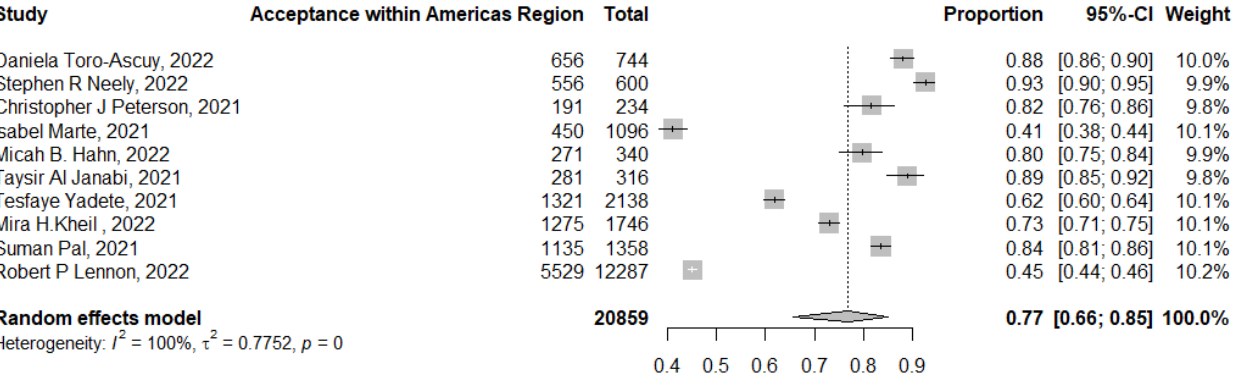
Figure 7. Acceptance of COVID-19 booster dose vaccination in the WHO region of the Americas. p = 0 denoted a p -value < 0.001.